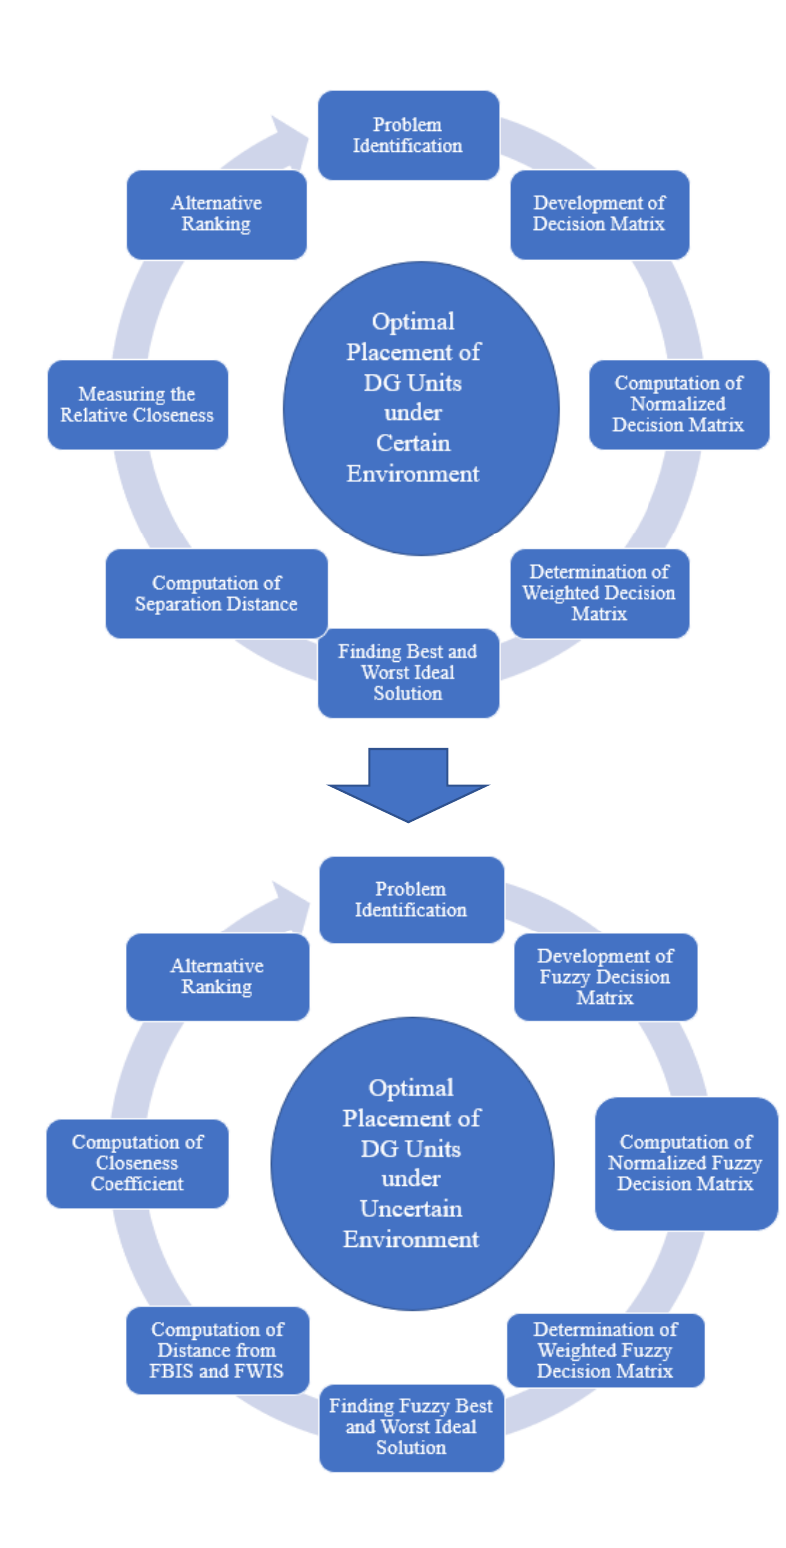
Figure 2. Research framework for identification of DG